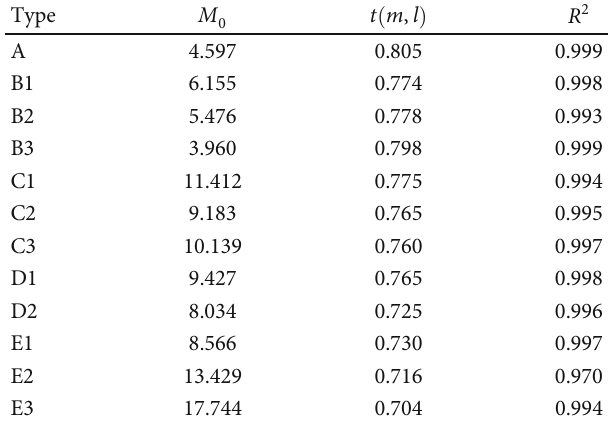
Table 3: Parameters of critical strength with di ff erent